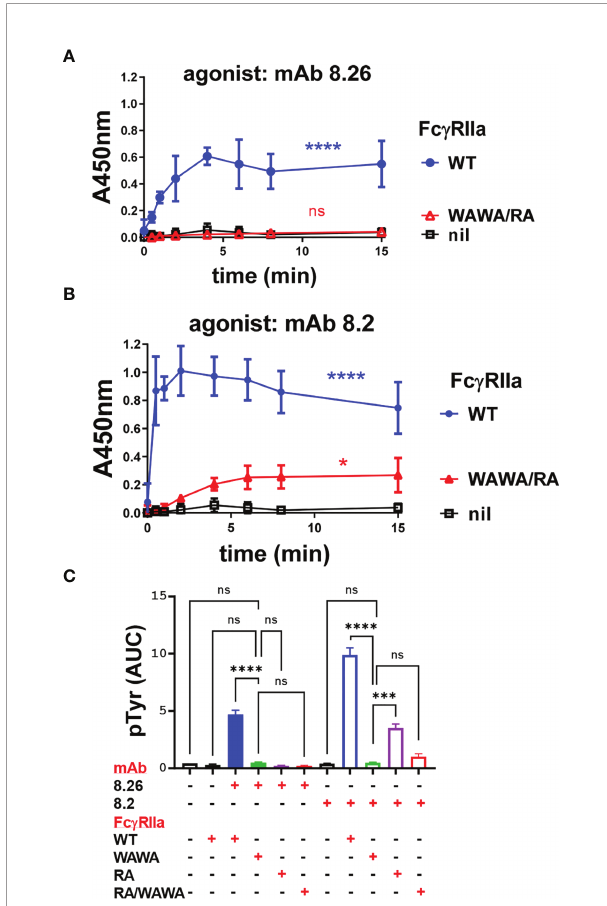
FIGURE 6 | (A, B) MAb 8.26 or 8.2 induced Fc g RIIa tyrosine phosphorylation in IIA1.6 cells expressing wild type Fc g RIIa-WT, or co- expressing Fc g RIIa-WAWA and Fc g RIIa-RA or parental cells lacking Fc g R. Tyrosine phosphorylation was measured in the Fc g RIIa phosphorylation ELISA, n = 3. 2-way ANOVA with Dunnett ’ s multiple comparison test to untreated WT; ns-not signi fi cant, *p < 0.0332, ****p < 0.0001. (C) Area under curve analysis of the receptor activation in Figures 4A, B and Figures 6B, C . One-way ANOVA with Dunnett ’ s multiple comparison test showing comparison to Fc g RIIa-WAWA ***p 0.0003, ****p <